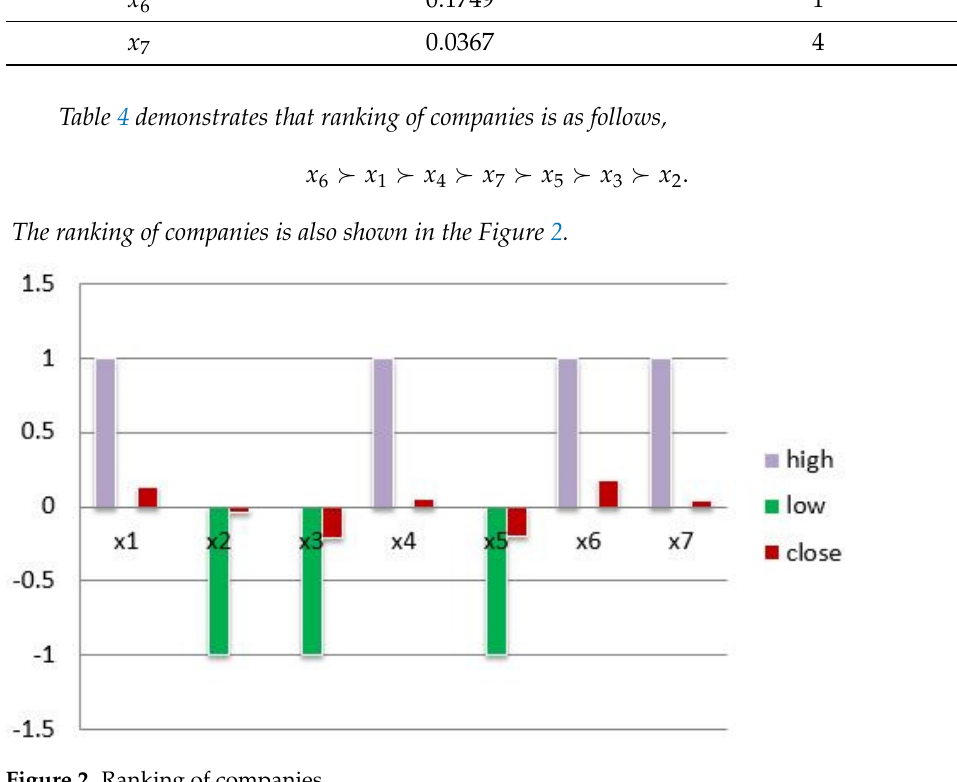
Figure 2. Ranking of